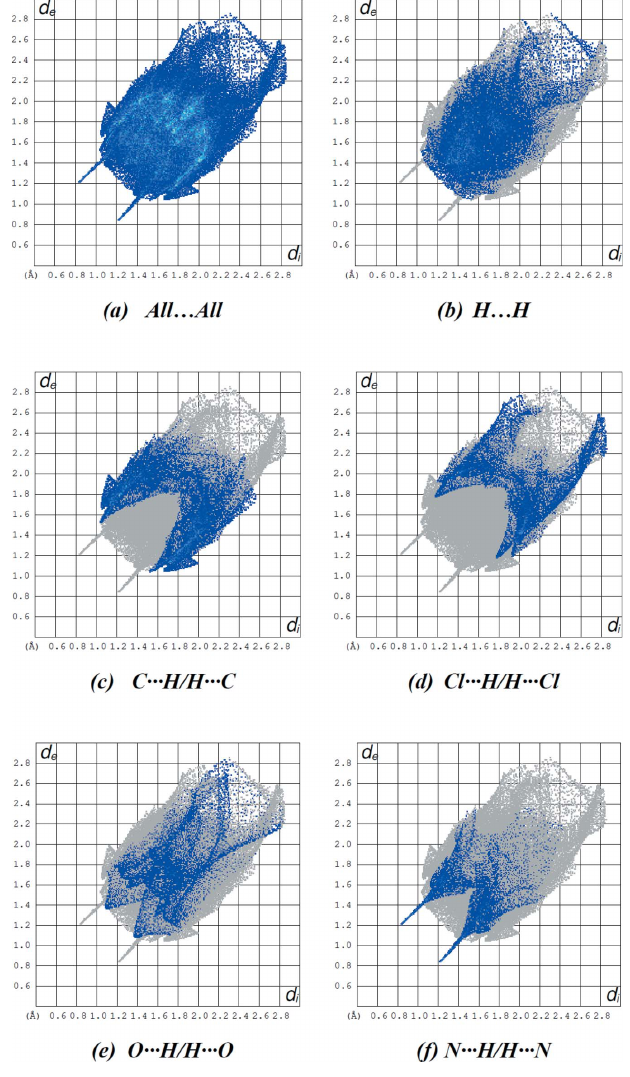
Figure 5 View of the three-dimensional Hirshfeld surface of the title compound plotted over electrostatic potential energy in the range (cid:5) 0.0500 to 0.0500 a.u. using the STO-3 G basis set at the Hartree–Fock level of theory. Hydrogen-bond donors and acceptors are shown as blue and red regions, respectively, around the atoms, corresponding to positive and negative potentials.